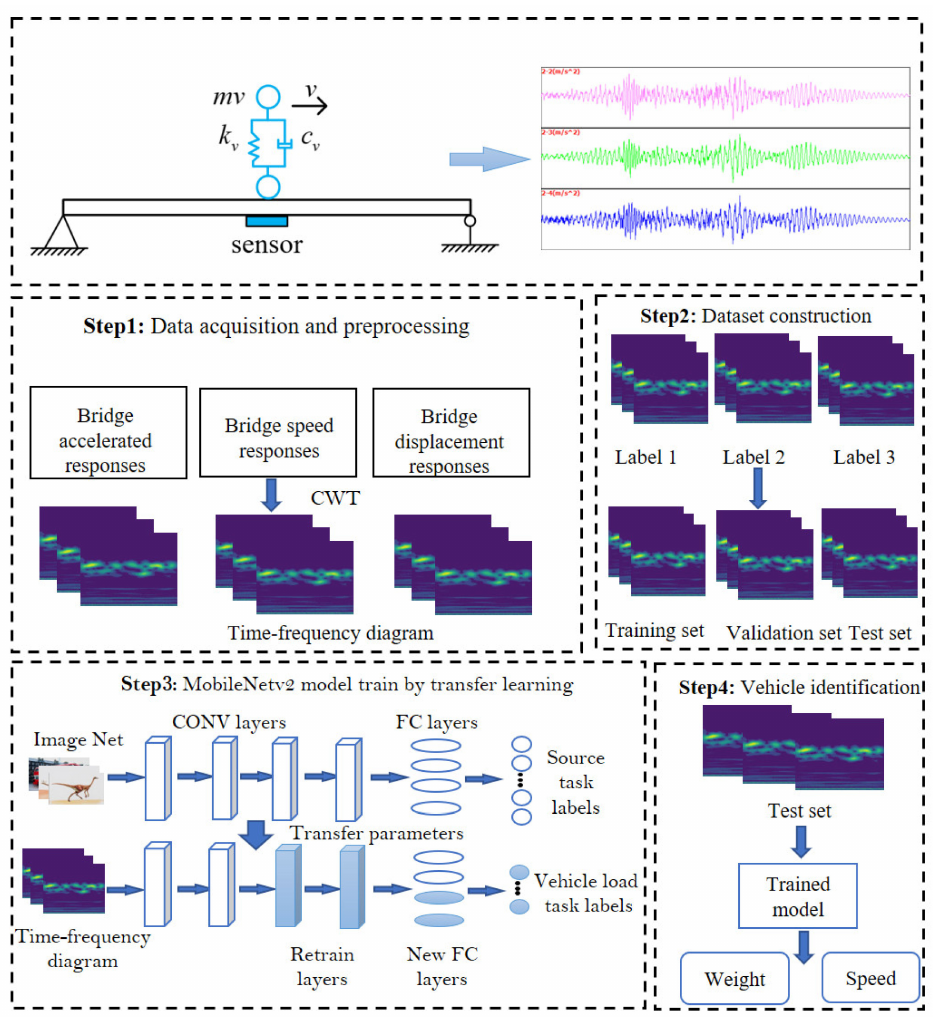
Figure 4. Overview of the proposed